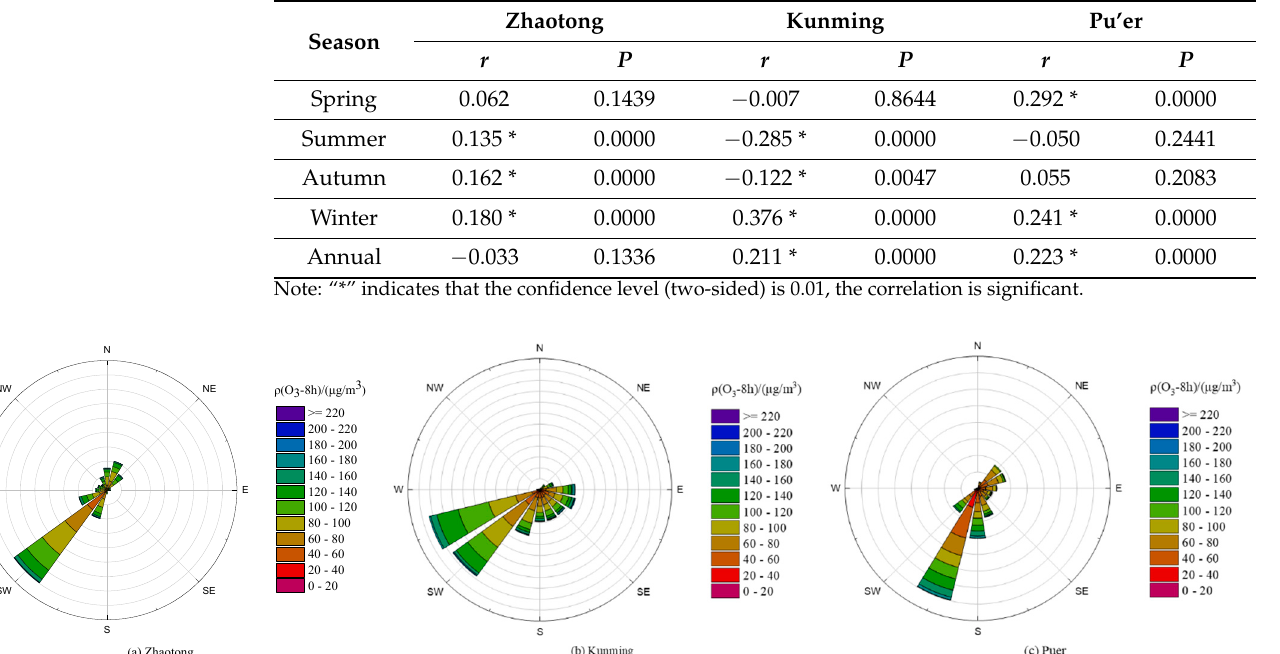
Table 3. Correlation Analysis of O 3 Concentration and Wind Speed in Different Seasons.